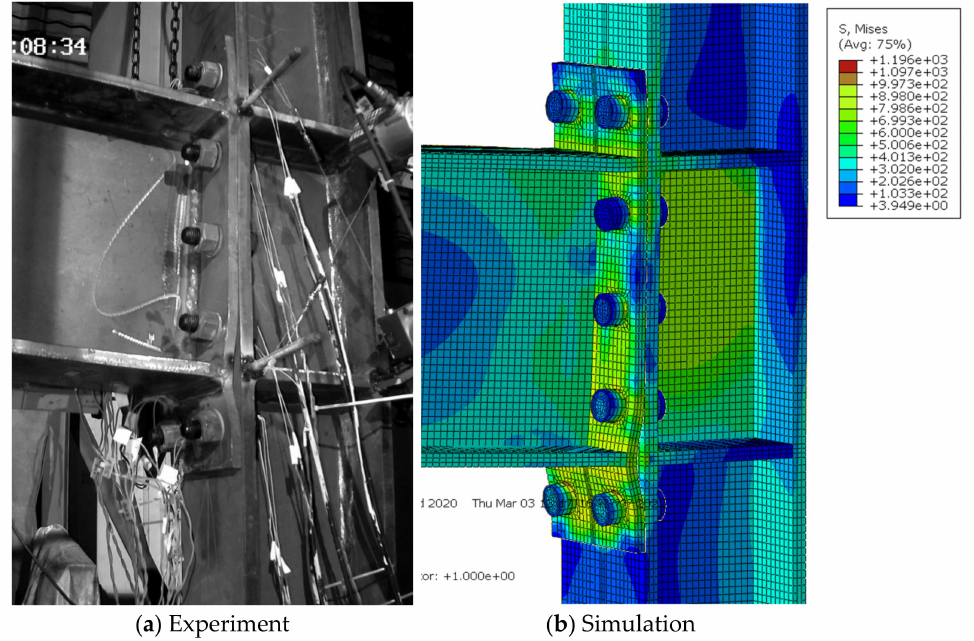
Figure 7. Comparison of experimental and simulated deformation modes in specimen S2 at the second negative peak of 5% loading